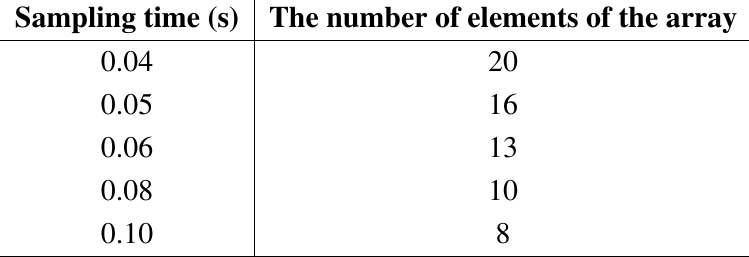
Table 4. Various sampling times for transitional